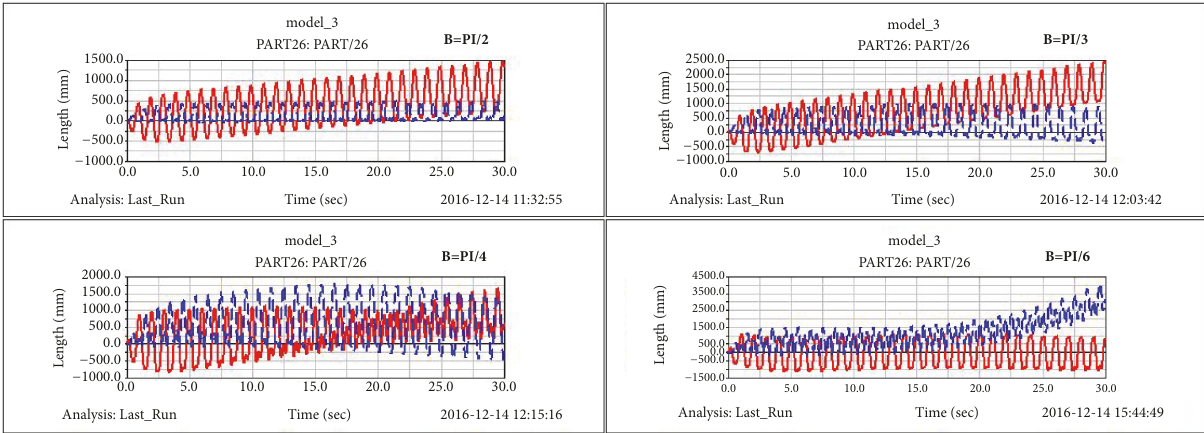
Figure 15: Displacement curve of different B